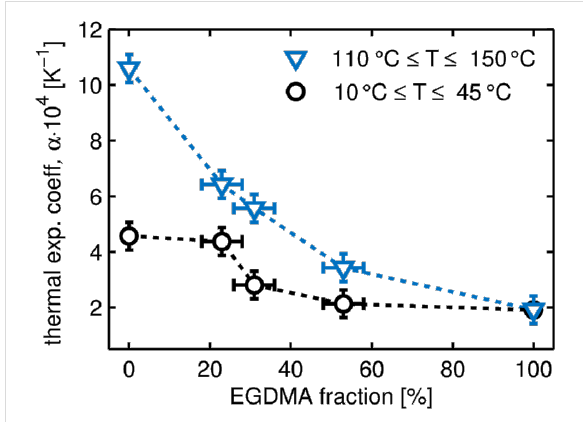
Figure 8: Coefficient of linear thermal expansion, α , as a function of EGDMA cross-linker fraction for various p-(PFDA- co -EGDMA) films in two temperature regions. The data points are interconnected by dashed lines as a guide to the